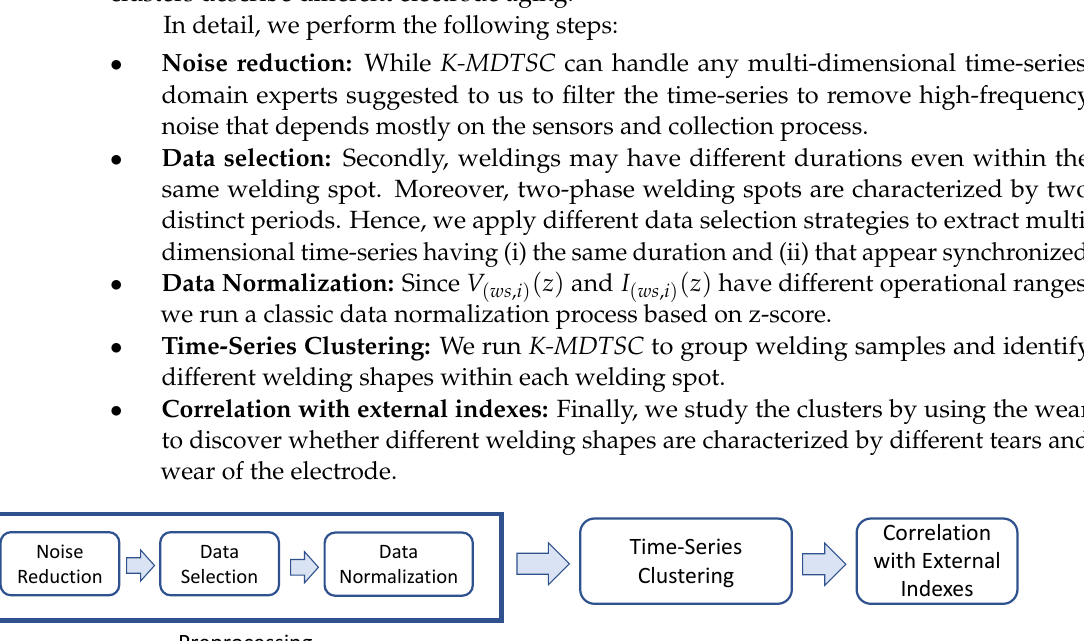
Figure 7. Pipeline of the data